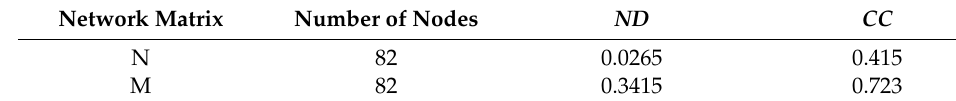
Table 3. Comparison of indicators for the M and N matrices.